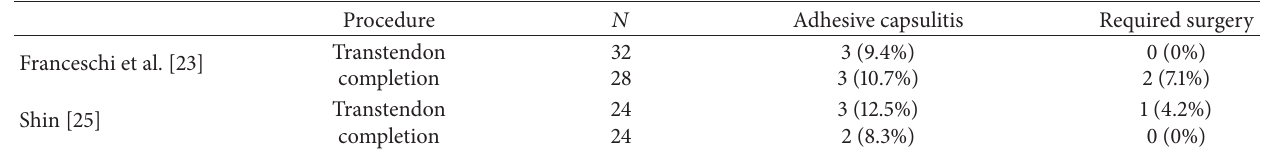
Table 7: Postoperative